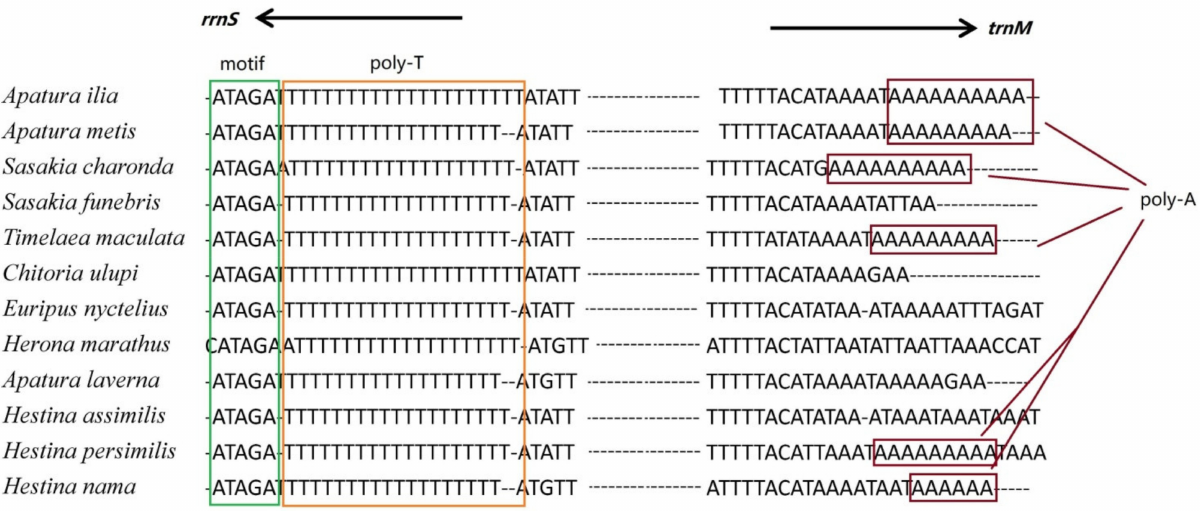
Figure 10. Alignment of motif, Poly(T) and poly(A) in control regions of twelve species in